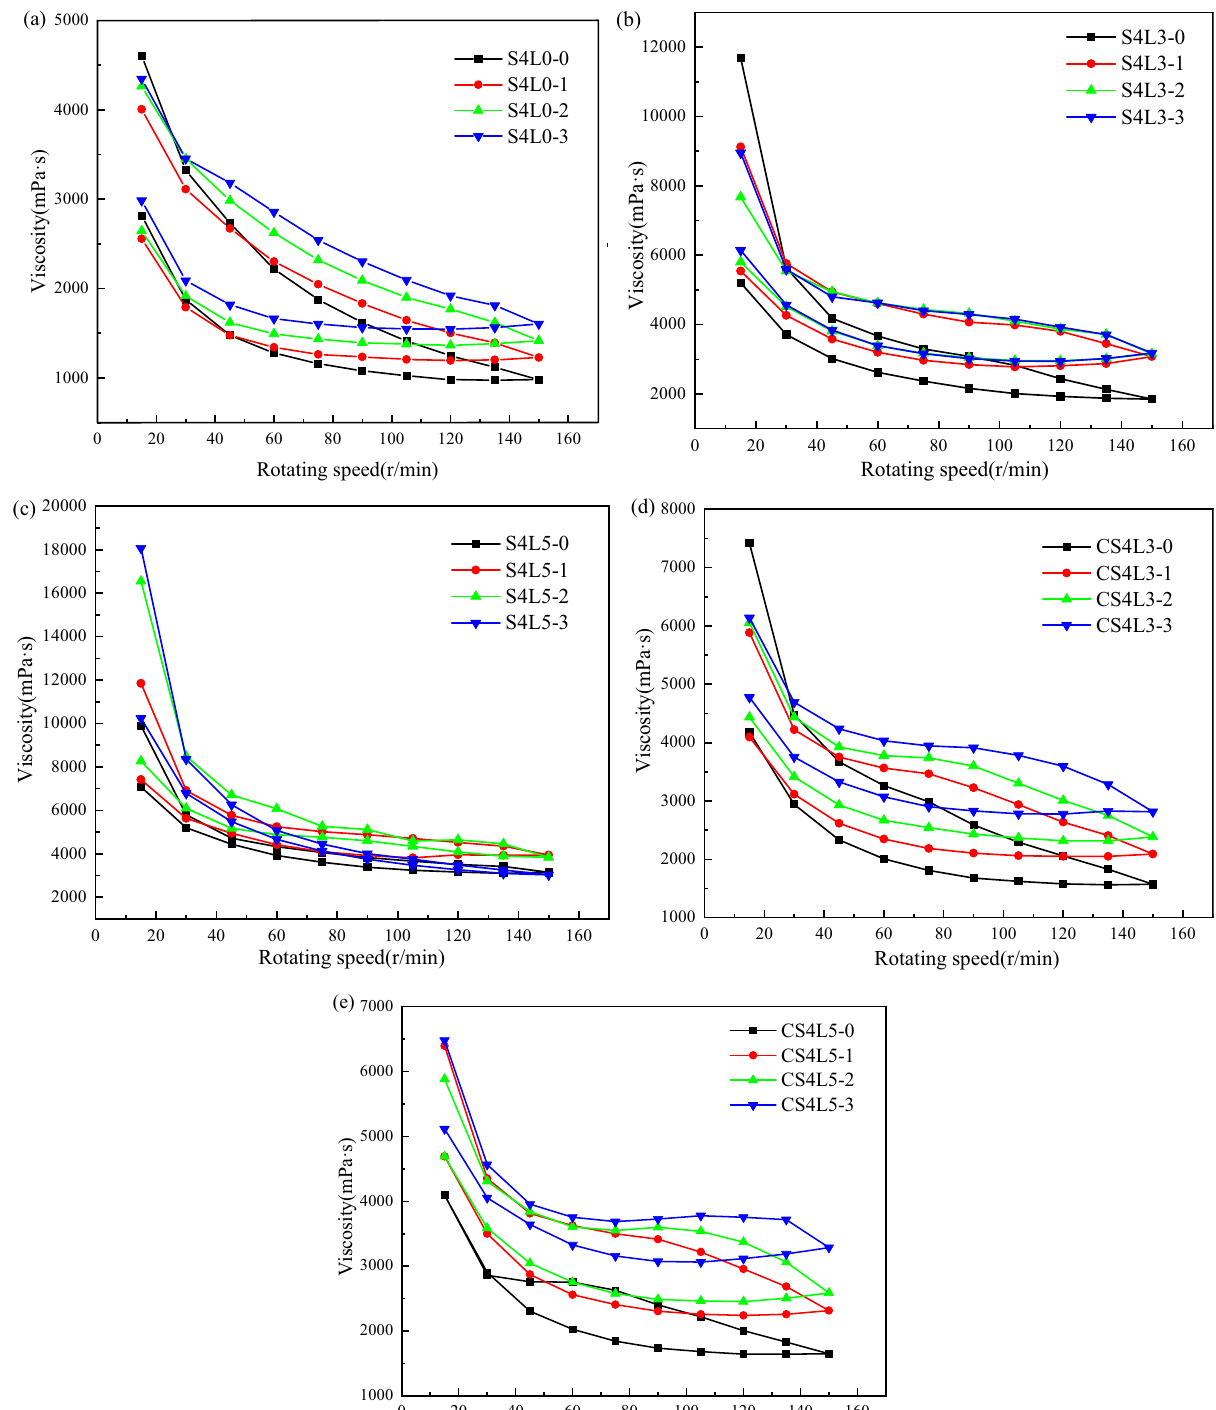
Figure 6: Viscosity test results: ( a ) S4L0, ( b ) S4L3, ( c ) S4L5, ( d ) CS4L3, and ( e )